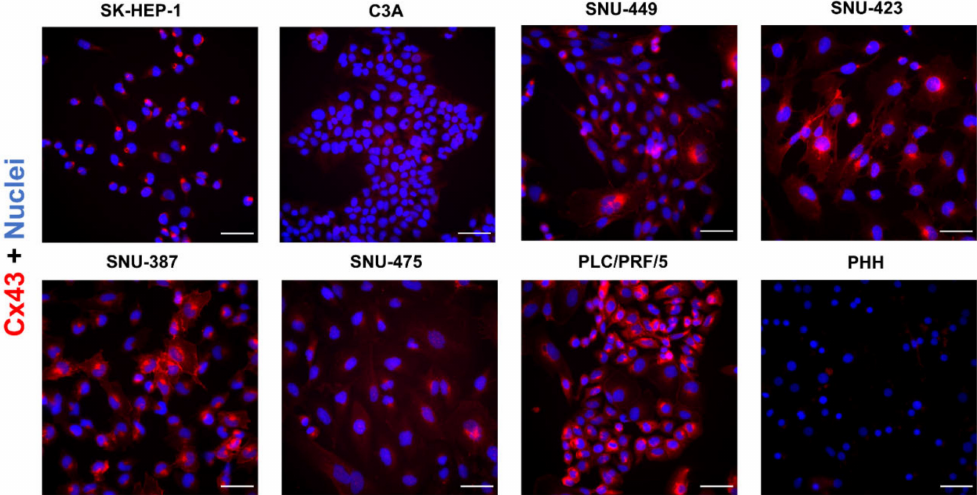
Figure 6. Cx43 protein localization in liver cancer cell lines and primary human hepatocytes (PHH). Cancer cell lines ( n = 1, N = 2) were fixed during the exponential growth phase, while PHH were fixed at the final day of the sandwich cultivation period. All cells were immunostained for Cx43 (red) with nuclear counterstaining using 4 (cid:48) ,6-diamidino-2-phenylindole (DAPI) (blue). Scale bar = 50 µ m. Images were taken with a 40 × objective. A representative image is